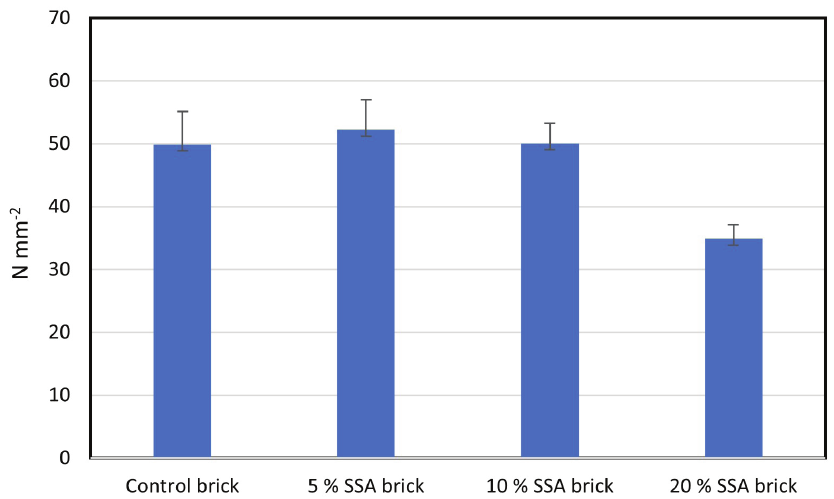
Fig. 5 – Compressive strength of the manufactured